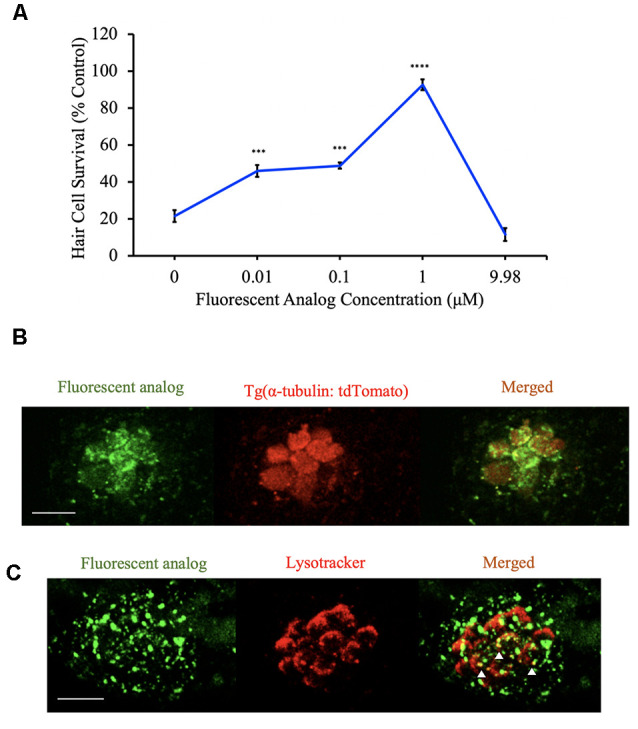
Berbamine analogs enter hair cells. (A) The dose-response curve for the fluorescent analog (BA-17) demonstrates significant protection from 200 μM neomycin. Hair cells were assessed via DASPEI. Data are normalized to controls. One-way ANOVA, F(4,49) = 50.22, p < 0.0001. N = 10–12, ****p < 0.0001, ***p < 0.001, bars are ± SEM. (B)
Tg(α-tubulin: tdTomato) zebrafish were pretreated with BA-17 for 1 h before imaging on a confocal microscope. Fluorescent analog (green) is present in hair cells (red). Scale bar = 10 μm. (C) AB zebrafish were pretreated with BA-17 for 1 h followed by a 3-min exposure to 50 nM LysoTracker before confocal imaging. Fluorescent analog (green) does overlap with lysosomes (red) in some areas (white arrowheads). Scale bars in (B,C) = 10 μm.